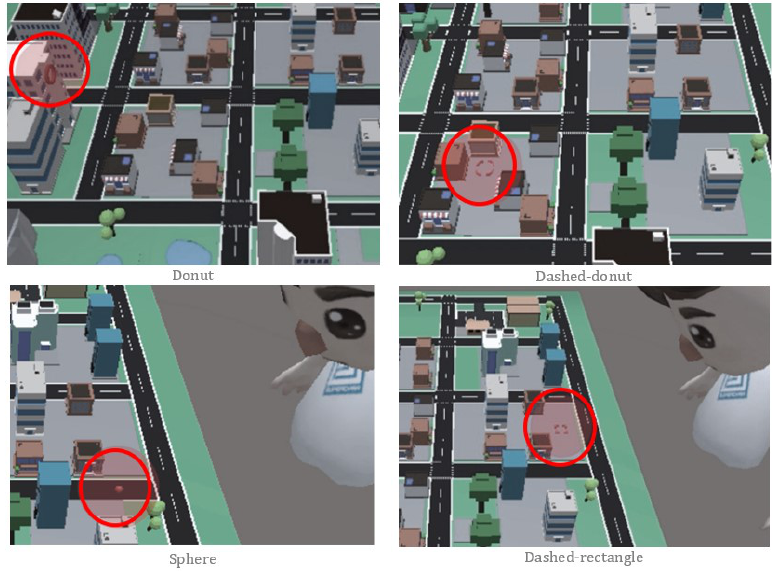
Figure 3. Visualization design variants for the